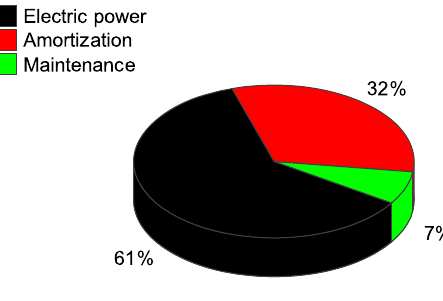
FIG. 28. Breakdown of the processing